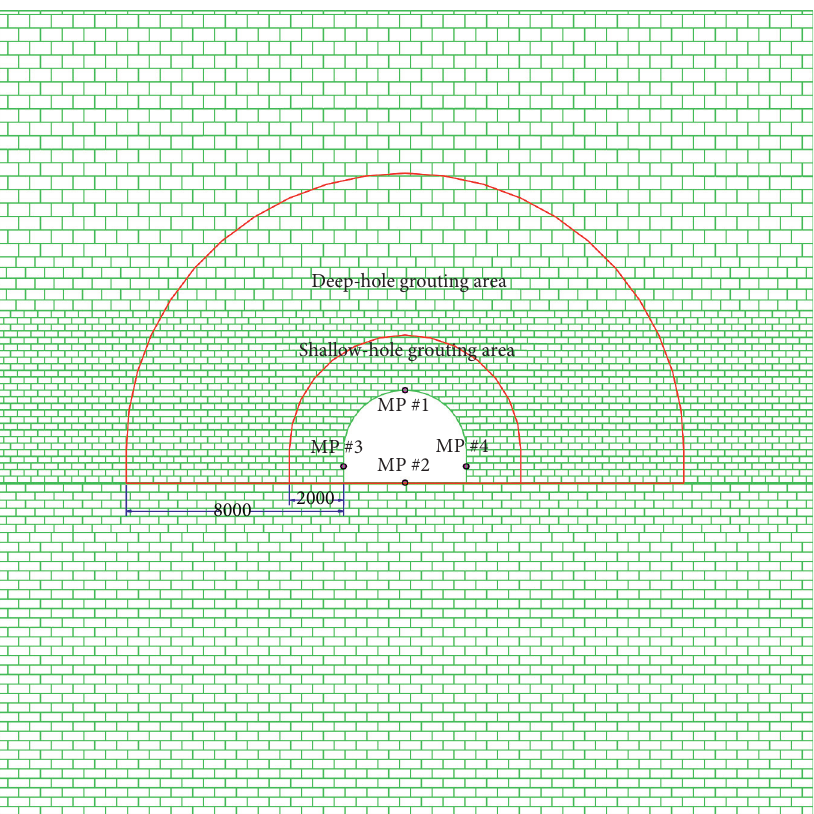
Figure 12: Grouting model for the surrounding rock in the permanent refuge chamber.